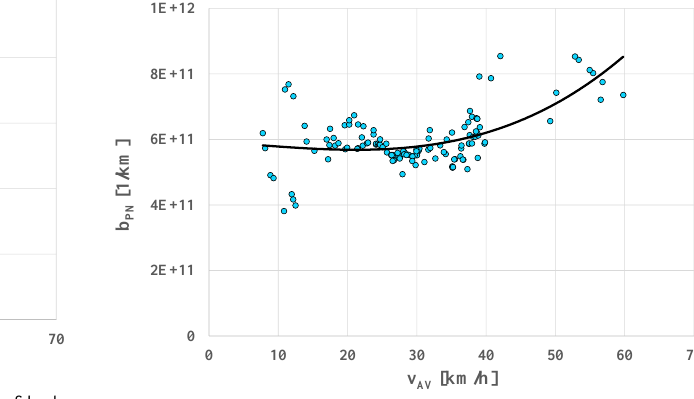
Fig. 14. Dependence of the average specific distance emission of hydro carbons on the average vehicle velocity in the Malta test